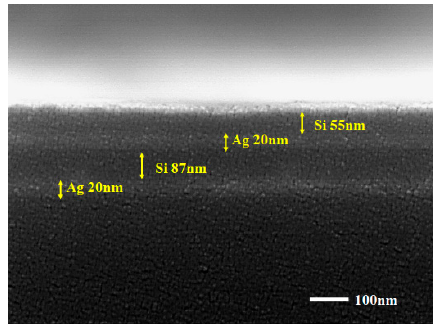
Figure 4. Scanning electron microscope (SEM) image of cross-section of fabricated sample; thicknesses of layers N i / D 1 M 2 D 3 M 4 / N sub = air/a-Si (55 nm)/Ag (20 nm)/a-S i(87 nm)/Ag (20 nm)/glass.